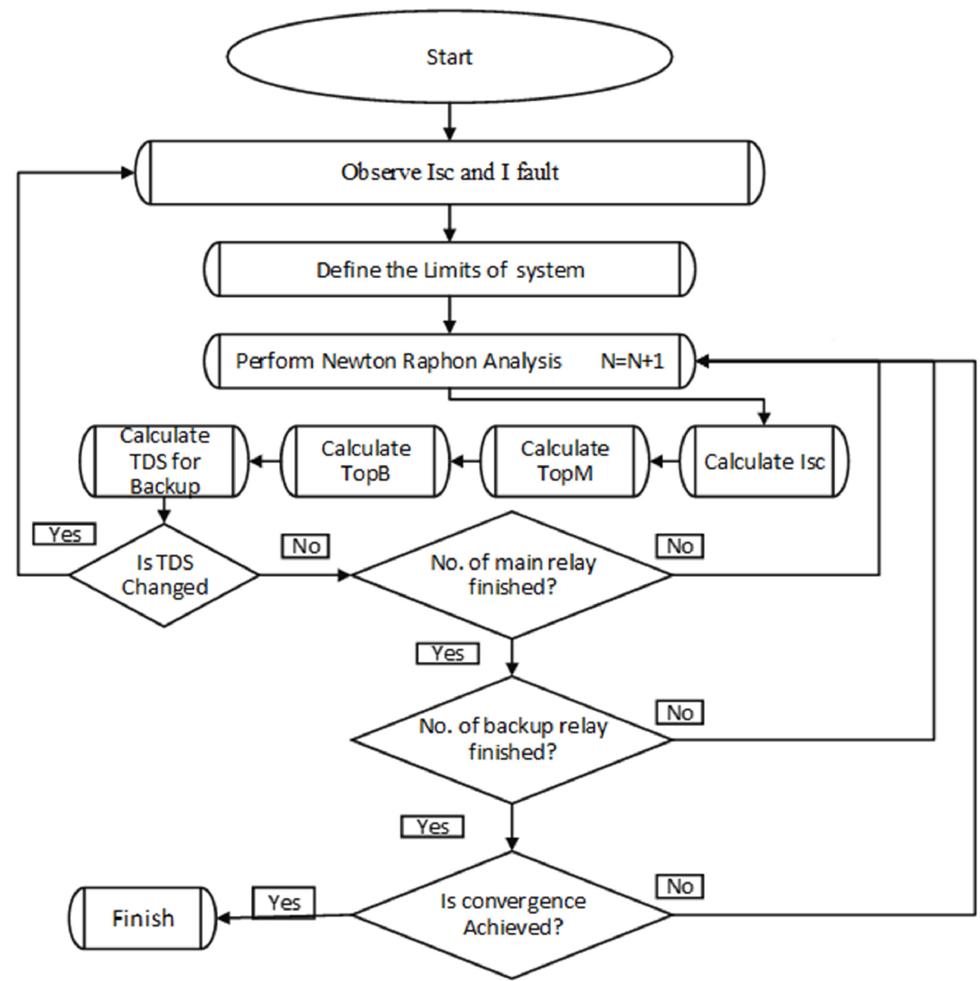
Figure 5. Flowchart of timing relay for coordination in the protection zone.